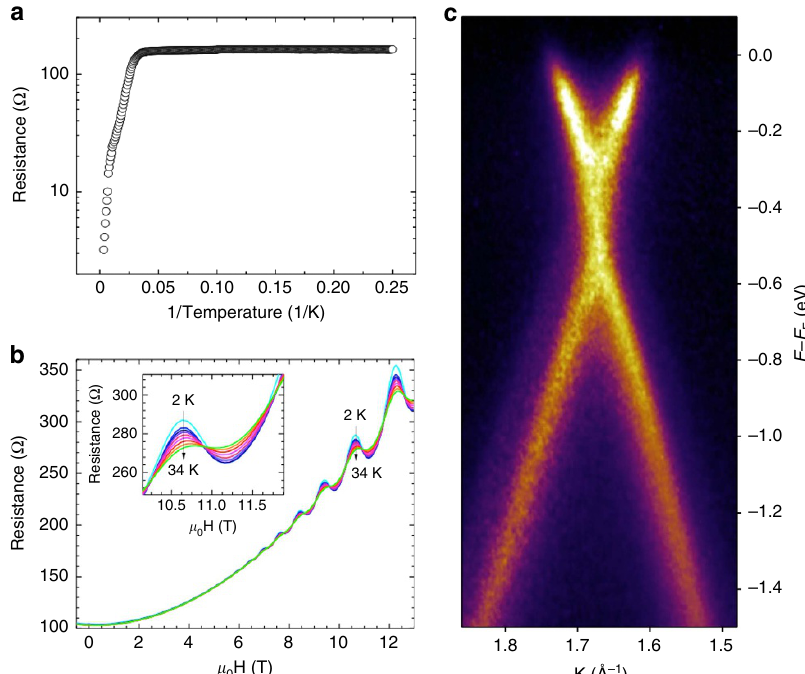
Figure 5 | The electric and electronic graphene features remain unaltered after p-AP functionalization. ( a ) Resistance versus inverse temperature at zero field for the p-AP functionalized sample. ( b ) Shubnikov–defHaas oscillations for our functionalized graphene sample on a semi-insulator SiC substrate. ( c ) Photoemission momentum map of a p-AP functionalized SLG. Cut along k x direction. Photon energy: 34eV. NATURE COMMUNICATIONS|8:15306|DOI: